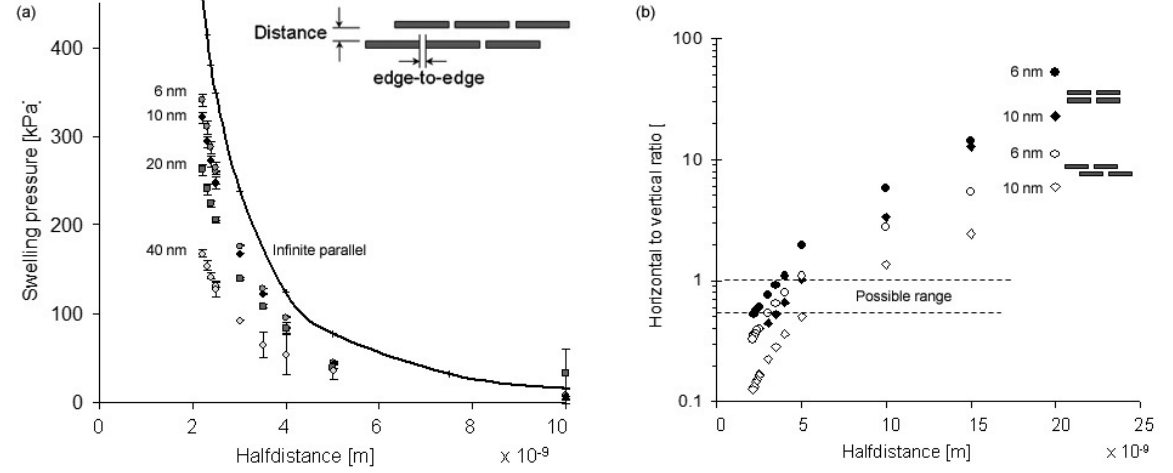
Fig. 6 – (a) Swelling pressure in shifted parallel finite size platelets fabrics ( c to edge separations of 40, 20, 10, 6 and → 0 nm (or infinitely long parallel platelets). (b) ratio of horizontal to vertical swelling pressure, K o , estimated for stacked (solid symbols) and shifted (open symbols) fabrics, for 6 nm (circles) and 10 nm (rhombi) edge to edge